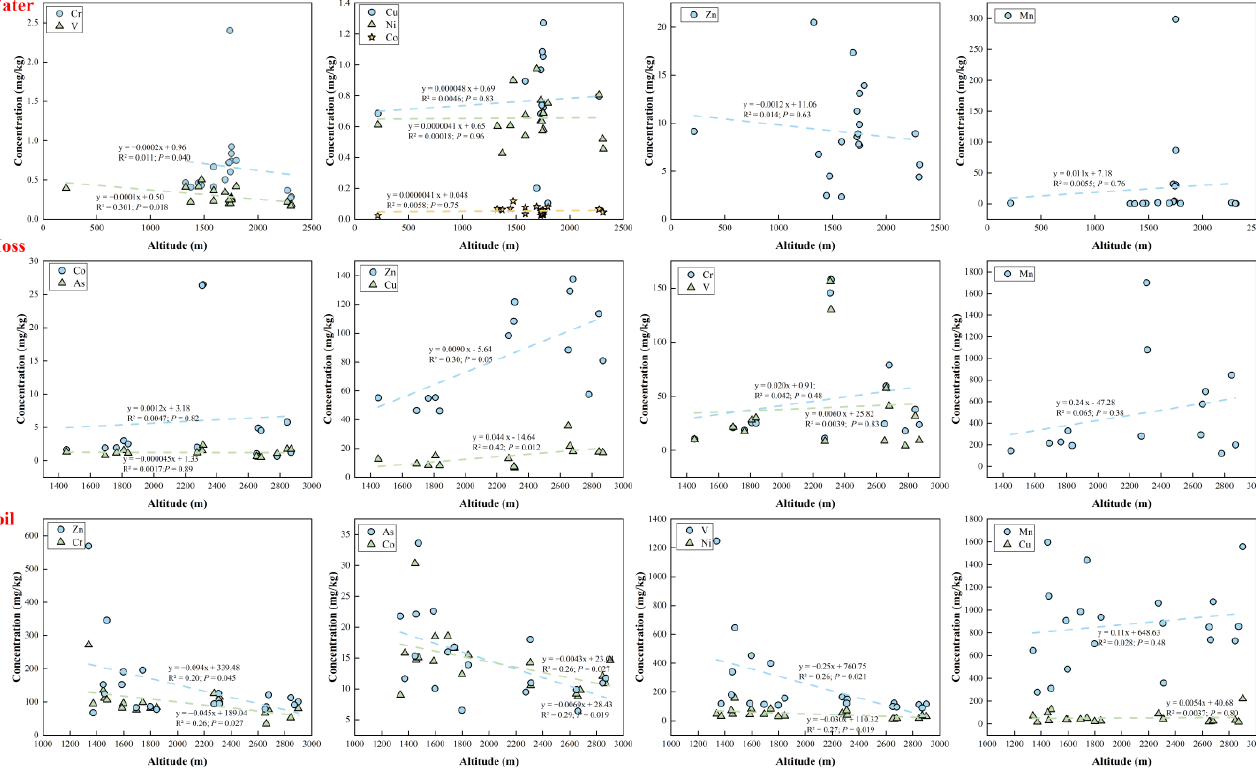
Figure 3. The distribution of SNJ soil, moss, and water metal(loid) contents with altitude. (The dashed lines represent the linear regression of data.)